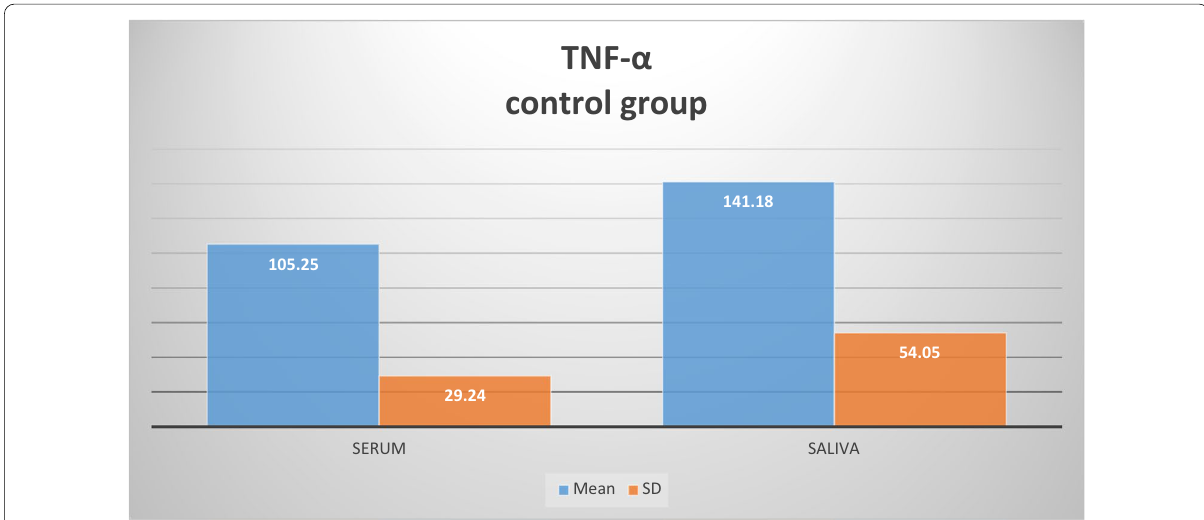
Fig. 8 Bar chart showing mean and standard deviation of TNF-α in saliva and serum in control group